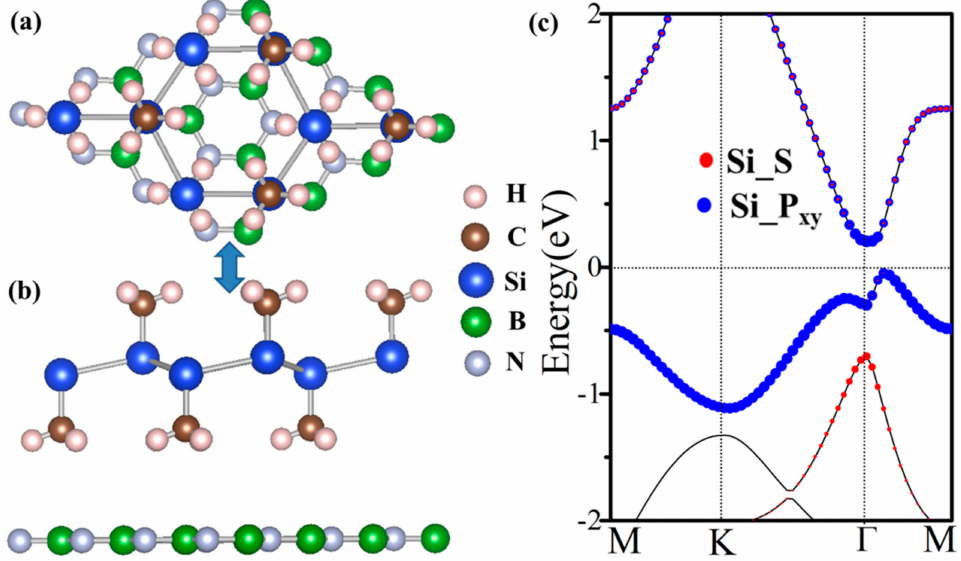
Figure 6. ( a ) Top and ( b ) side views of the epitaxial growth SiCH 3 on 2 × 2 BN substrate; ( c ) The corresponding energy band structure with